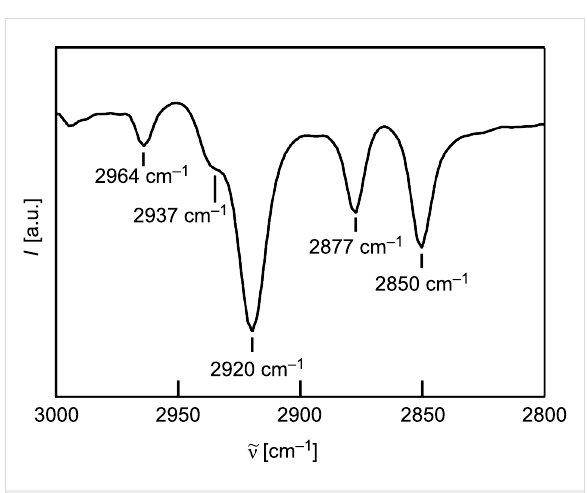
Figure 3: IRRAS-spectra of an HDT-coated Au/glass substrate exposing a 50 nm Au layer.